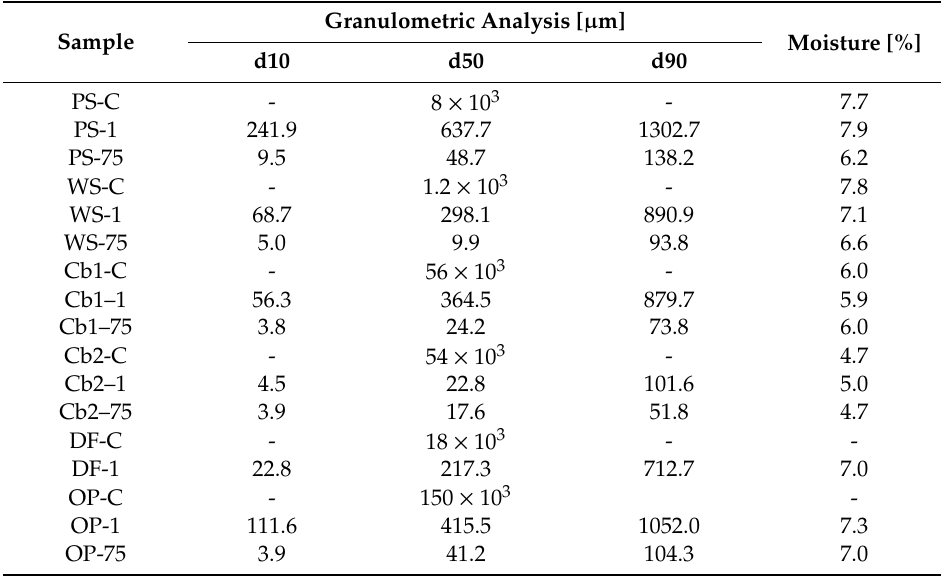
Table 2. Sample particle size and